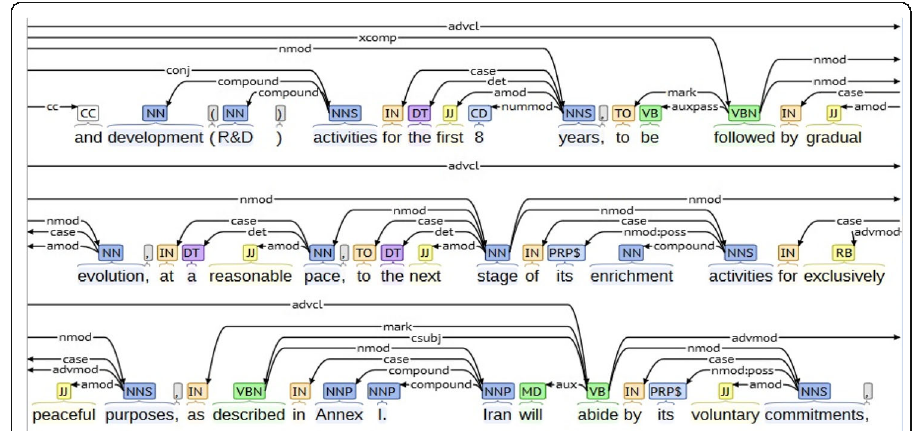
Fig. 5 TranslationQ platform. TranslationQ was considered a revision memory and likewise CPIE had the potential to be applied in the TranslationQ